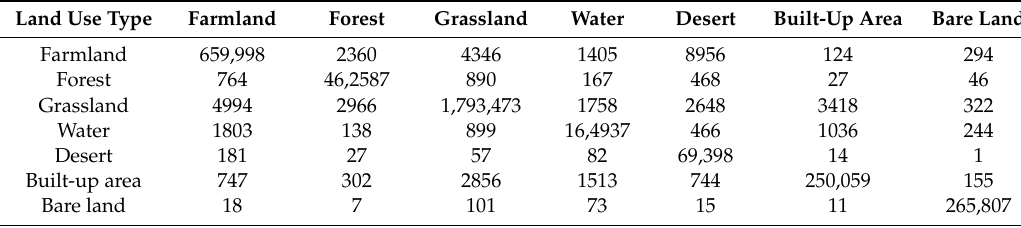
Table 1. Land use transfer matrix from 2000 to 2015 (km 2 ).